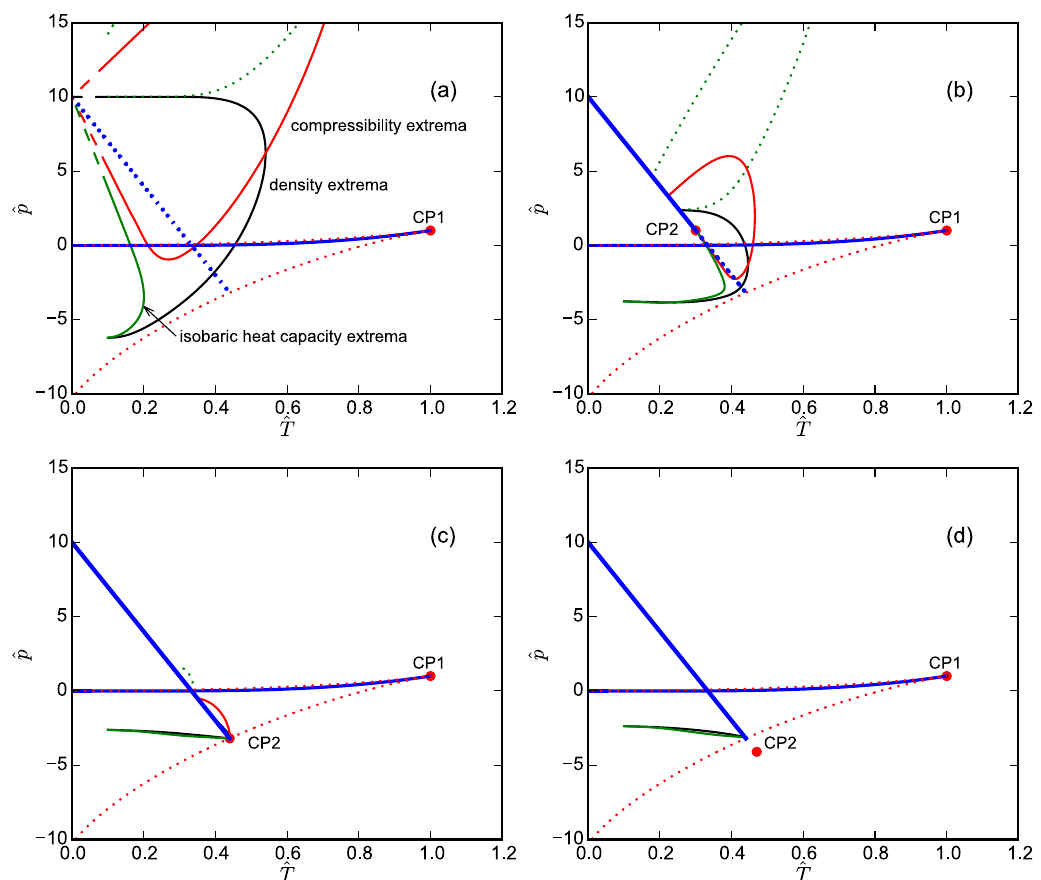
FIG. 4. Evolution of the pattern of the extrema loci upon tuning the location of the liquid-liquid critical point. Black is the density maximum or minimum; red is the isothermal compressibility maximum or minimum along isobars; green is the isobaric heat capacity maximum or minimum along isotherms; dotted green shows additional (shallow) extrema of the heat capacity unrelated to the liquid- liquid transition; dotted red are two branched of the liquid-vapor spinodal; blue dashed is the Widom line; red dots are the vapor-liquid (CP1) and the liquid-liquid (CP2) critical points. (a) A “ singularity-free ” scenario — the critical point is at zero temperature, thus it is not labeled as CP2; extrapolations of the extrema loci to zero temperature are shown as dashed lines. (b) A “ regular ” scenario — the critical point CP2 is at a positive pressure. (c) The critical point coincides with the absolute stability limit of the liquid state. (d) A “ critical point- free ” scenario — the “ virtual ” critical point CP2 is located in the unstable